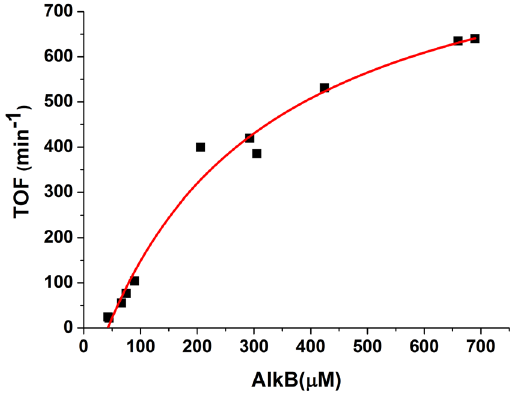
Figure 6. Specific activity in turnover frequency (TOF) with increasing concentration of AlkB bound to AlkG for the catalytic conversion of n -octane to 1-octanol. The red curve is resulted from the fitting using an apparent two-site binding model.